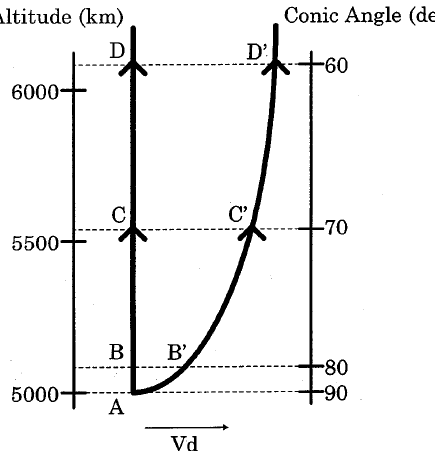
Fig. 3. A schematic drawing of the e(cid:128)ect of ion drifts on the spatial extension of observed ion conics region. We assume that ion conics with a conic angle of 90 (cid:14) are generated at point A . The ions flow up vertically due to the magnetic mirror force and move horizontally by the E (cid:2) B